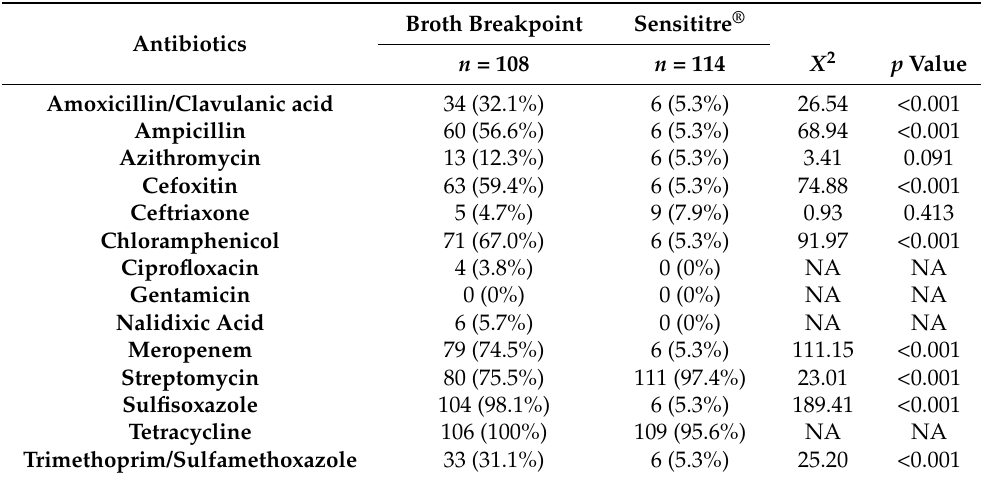
Table 4. Effects of antimicrobial susceptibility testing methodology on resistance ratios of poultry Salmonella isolated via selective enrichment in trial